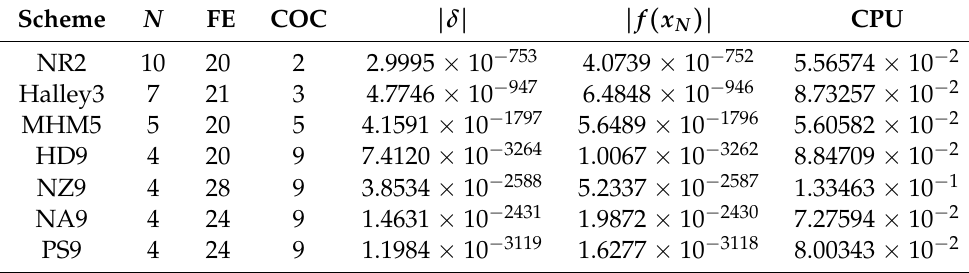
Table 8. Numerical results for the problem 3 with the initial guess h 0 = 8.5 m.